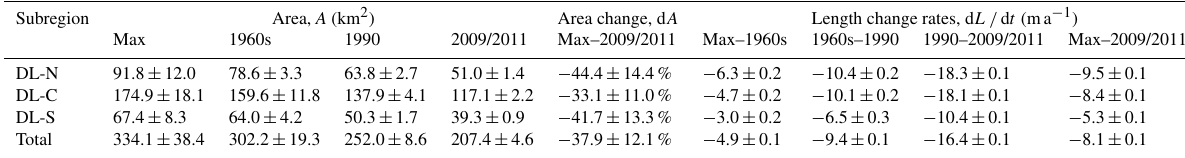
Table 1. Changing extent of glaciers in Dickson Land over the study periods.